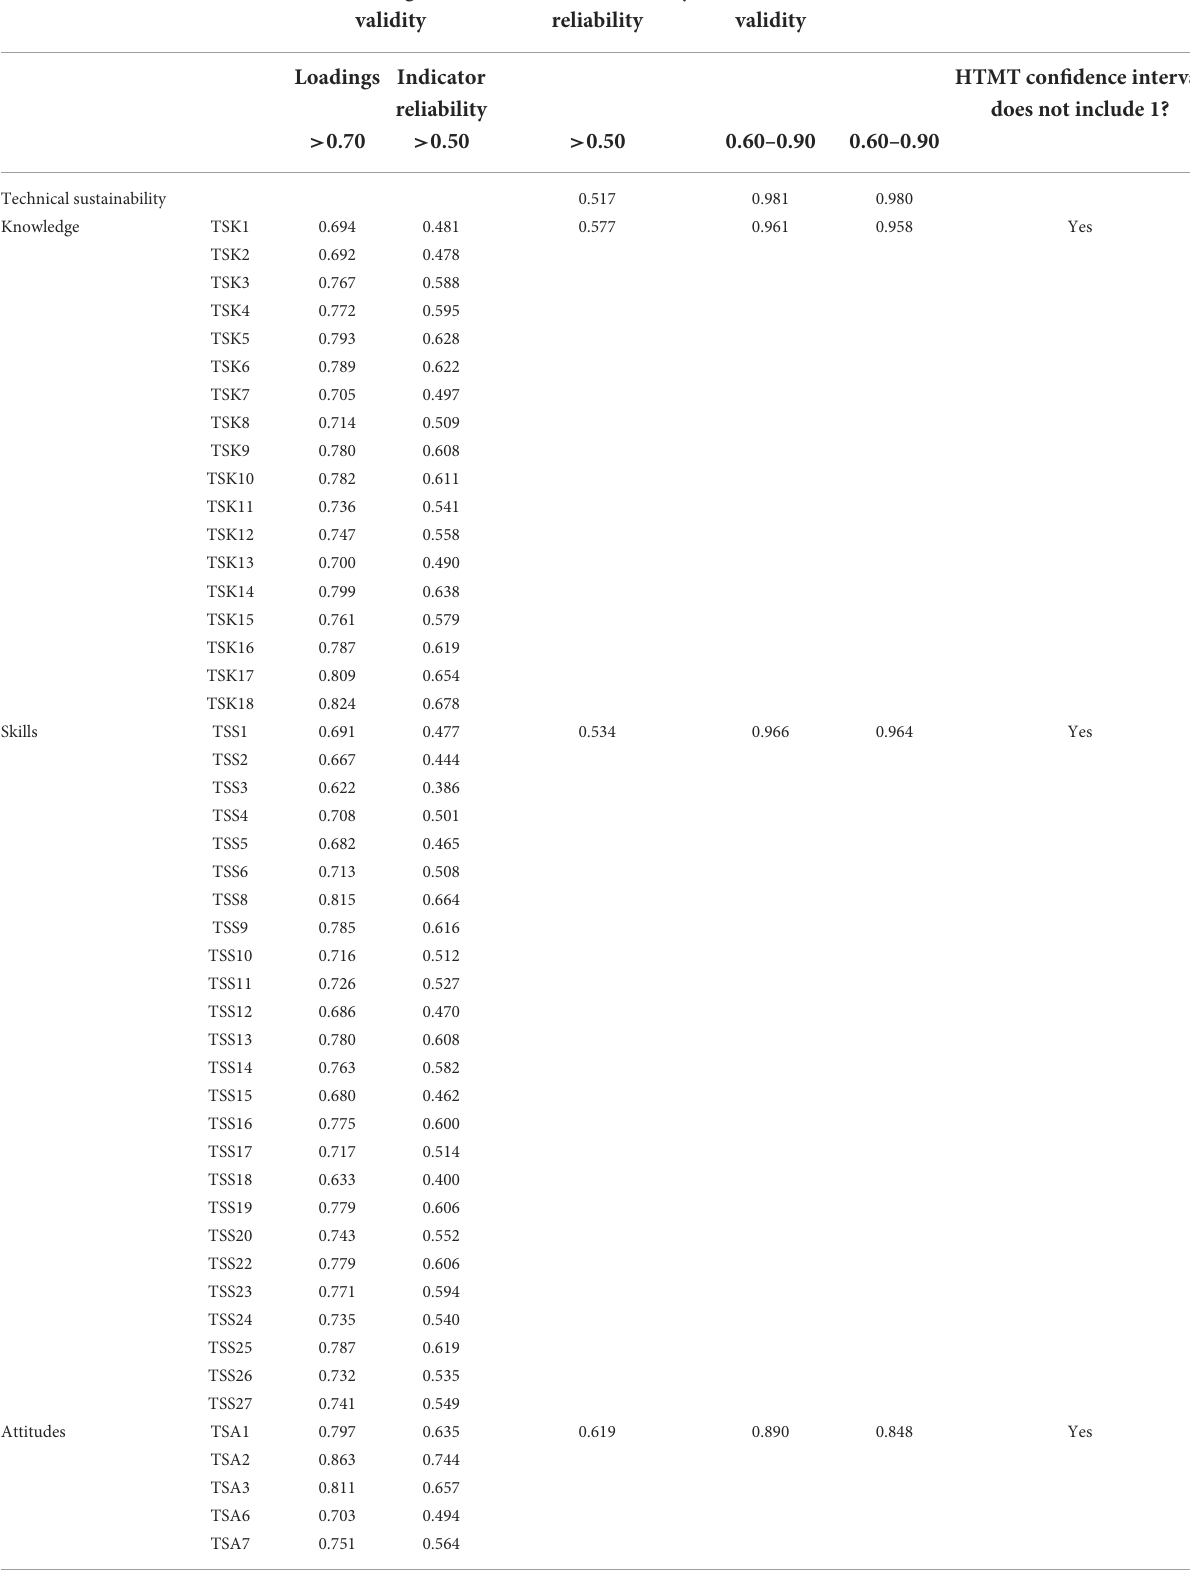
TABLE 1 Internal consistency reliability, convergent, and discriminant